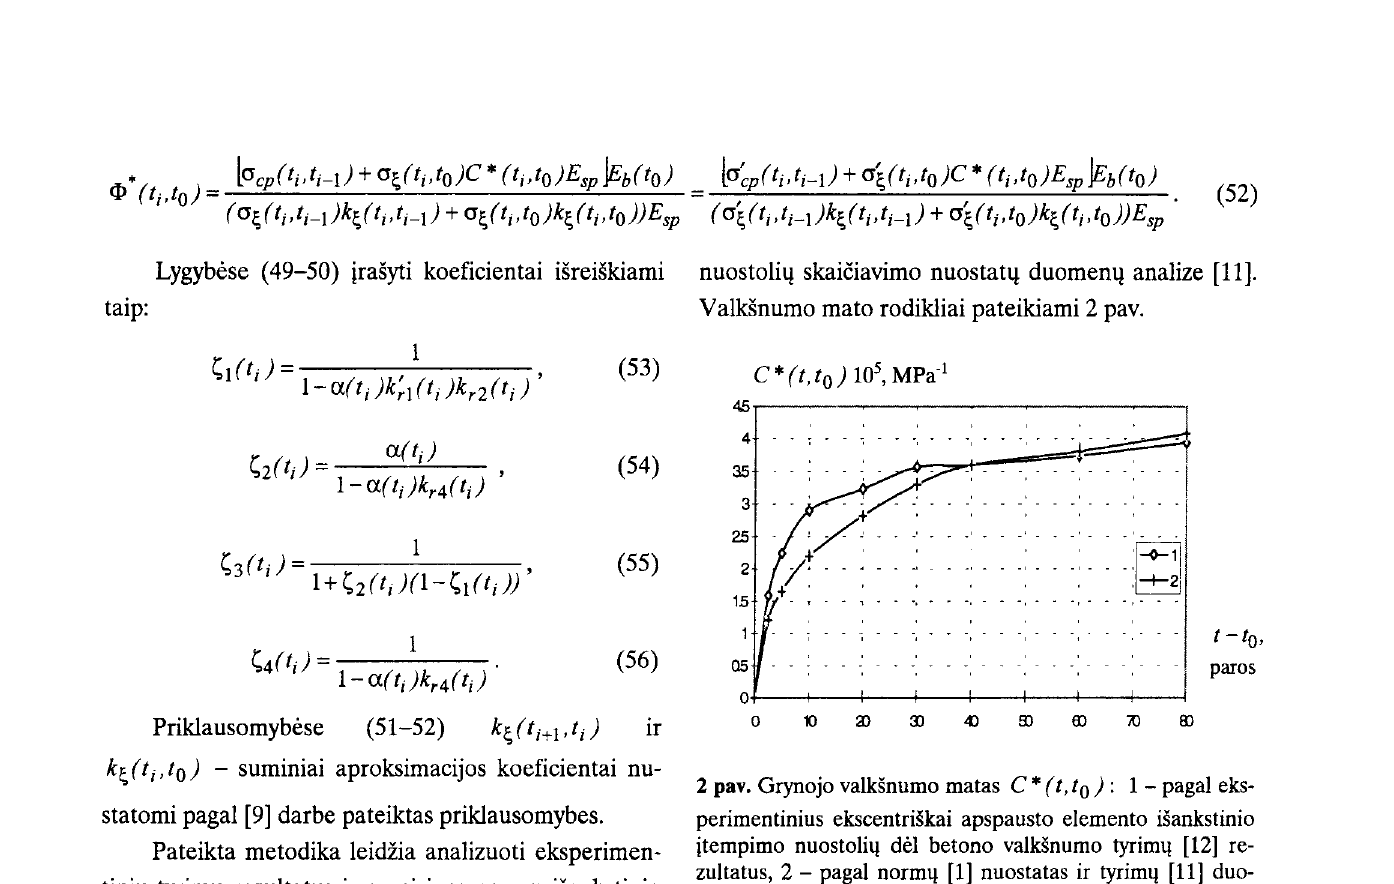
Fig 2. Pure specific creep C * ( t, t 0 ) : 1 - according to expe rimental investigations of prestress losses due to concrete creep in eccentrically prestressed member [12], 2 - accor ding to data of the Code [1] and investigation [11] 4. Normq EC-2 ir SNirT rekomendacijq vertinimas Pagal normas EC-2 [2] betono pradinil!